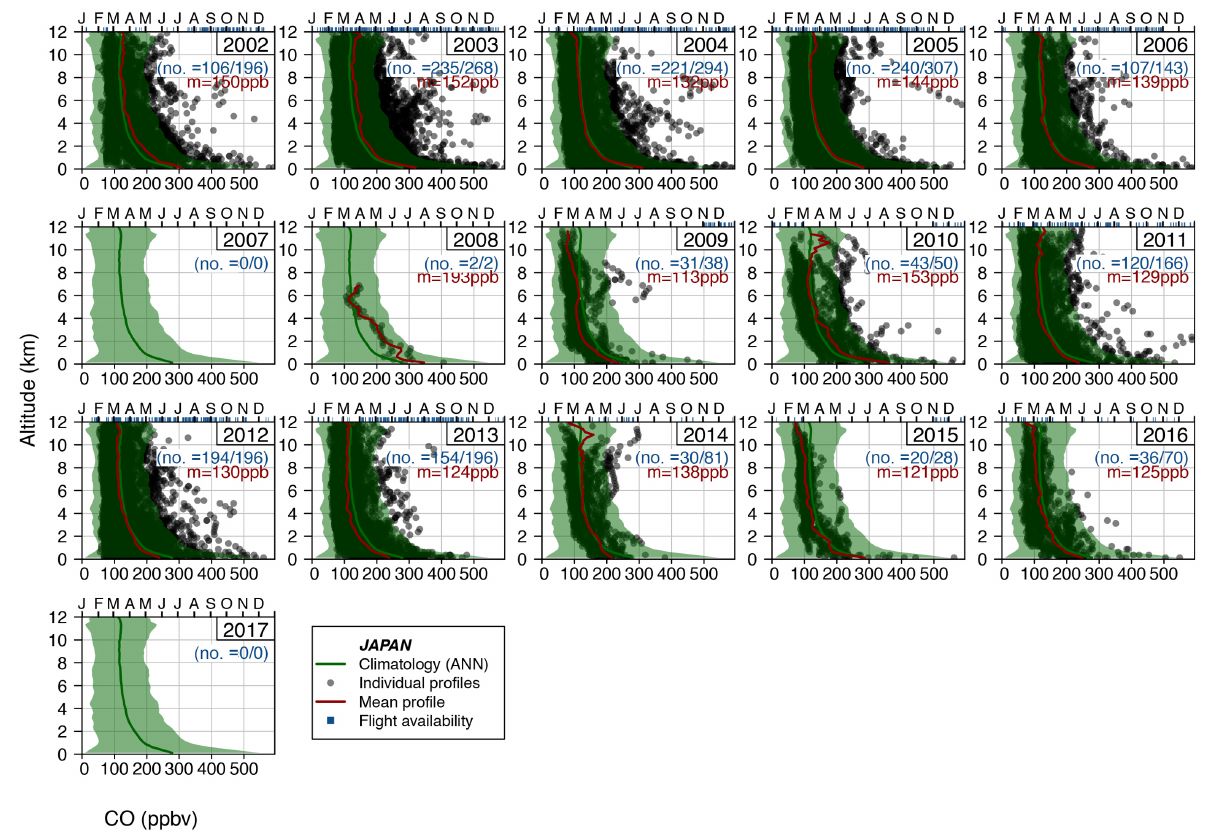
Figure 8. Same as Fig. 6 at the Japan